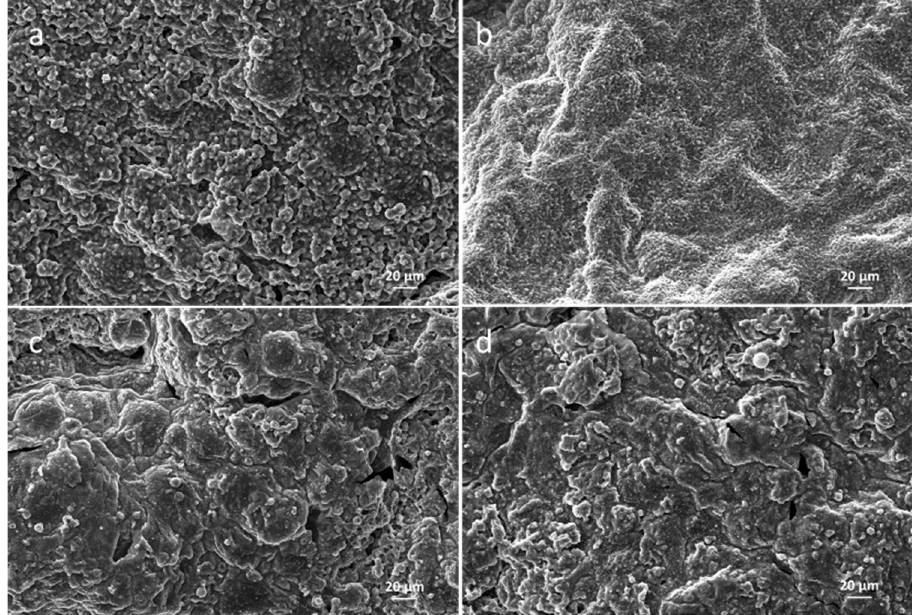
Figure 6. SEM micrographs of the char after CONE Testing of the composites. ( a ) PE/IFR, ( b ) PE/IFR/LDH, ( c ) PE/IFR/SLDH, and ( d ) PE/IFR/CLDH.